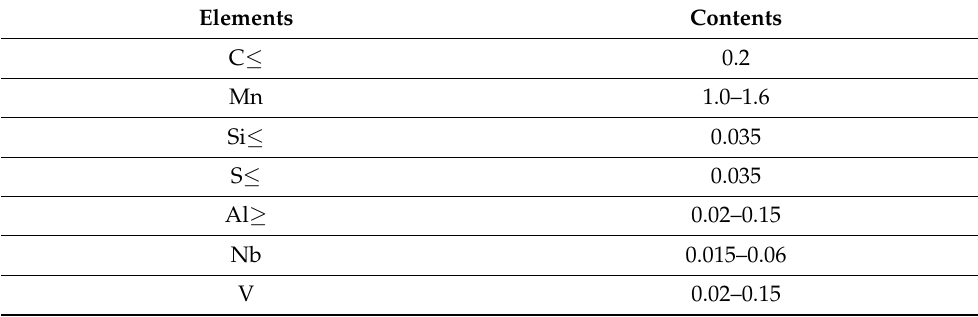
Table 2. Chemical composition of Q345B steel [78–80].